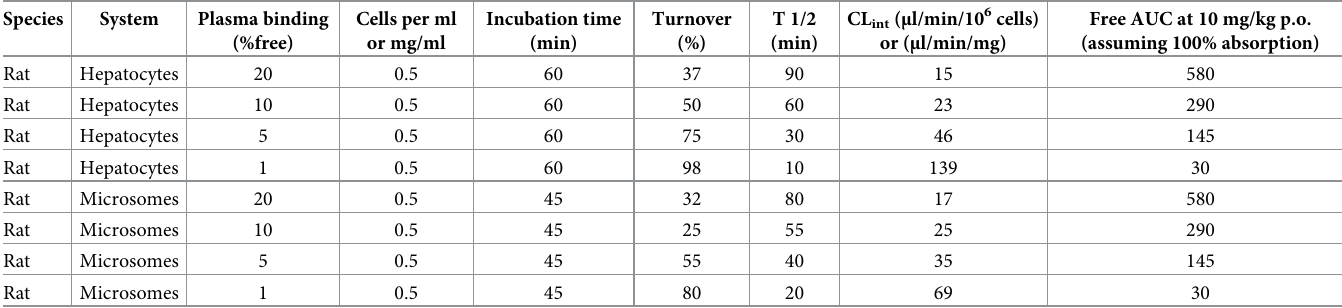
Table 1. In vitro data that would predict a hepatic extraction in the rat of 50%.